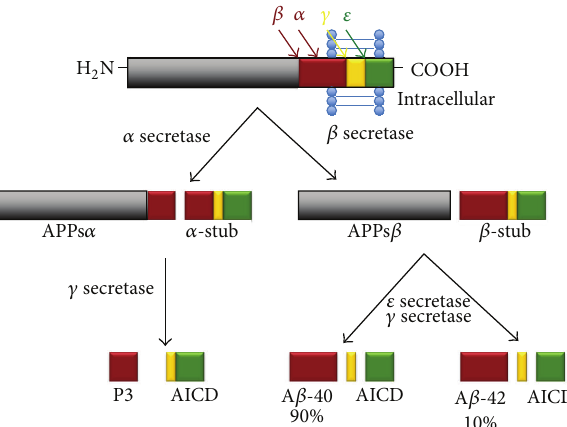
Figure 1: The processing of APP through the beta-site A 𝛽 PP- cleaving enzyme BACE1, followed by presenilin-1 (PS1). Sequential beta and gamma-secretase cleavage of APP generates the synapto- toxic amyloid- 𝛽 (A 𝛽 ) peptide species, A 𝛽 1-40 and A 𝛽